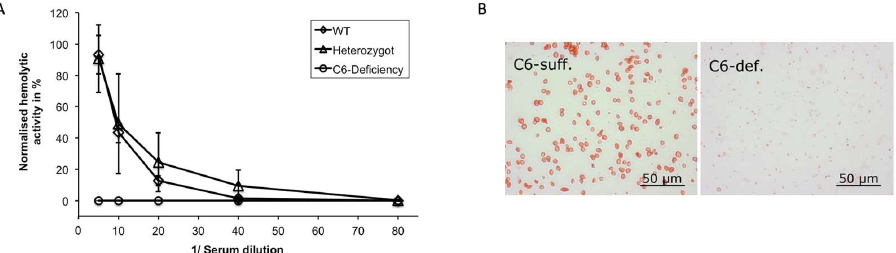
Figure 2. Functional testing of TCC in rabbit serum. ( A ) Hemolytic activity of rabbit serum derived from WT ( n = 3), heterozygote ( n = 8) and C6-deficient ( n = 9) animals was determined by means of a CH50 assay; curves represent column means at different dilutions with standard deviation. ( B ) Anti-TCC immunocytochemical staining of sheep erythrocytes exposed to C6-sufficient (C6-suff.) and C6-deficient (C6-def.) serum, respectively.